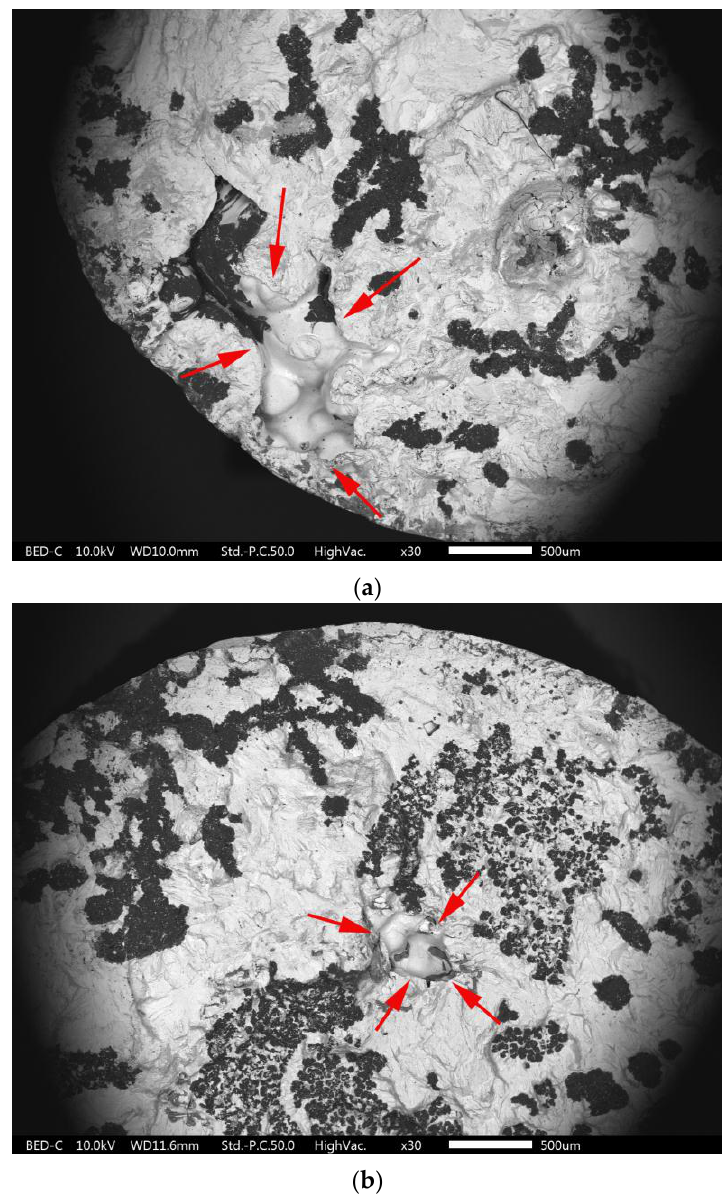
Figure 4. scanning electron microscope (SEM) micrographs of the fracture surfaces of rotating bending fatigue samples around the largest shrinkage pore marked by red arrows: ( a ) sample 6 (near-surface cavity); and ( b ) sample 8 (internal pore). Table 4 indicates stress amplitude and number of cycles to failure.